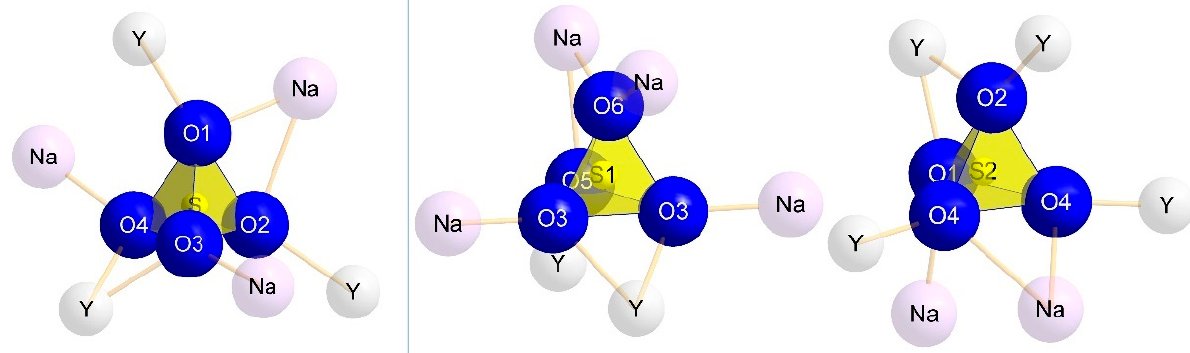
Figure 7. Coordination spheres of the tetrahedral oxosulfate anions [SO 4 ] 2– in NaY[SO 4 ] 2 · H 2 O ( left ) and NaY[SO 4 ] 2 ( right ).